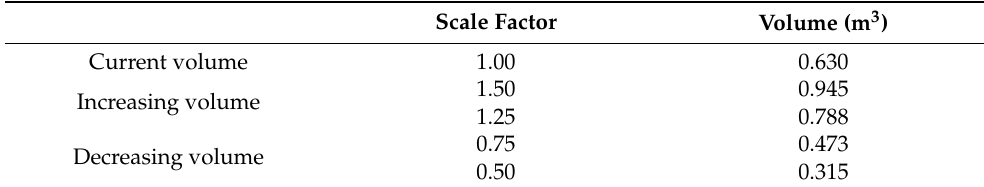
Table 6. Operating volume variations for the optimization of the feed-mixing